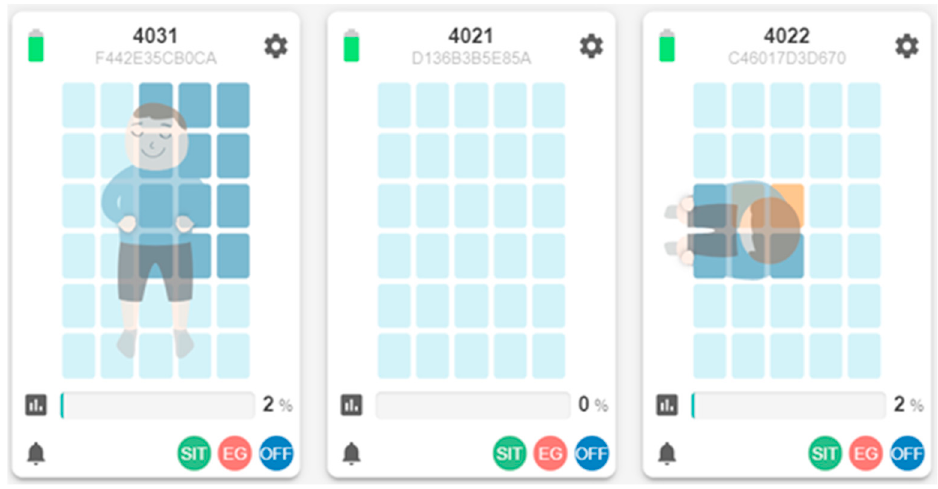
Figure 2. Real-time display of pressure pattern and in-bed posture.